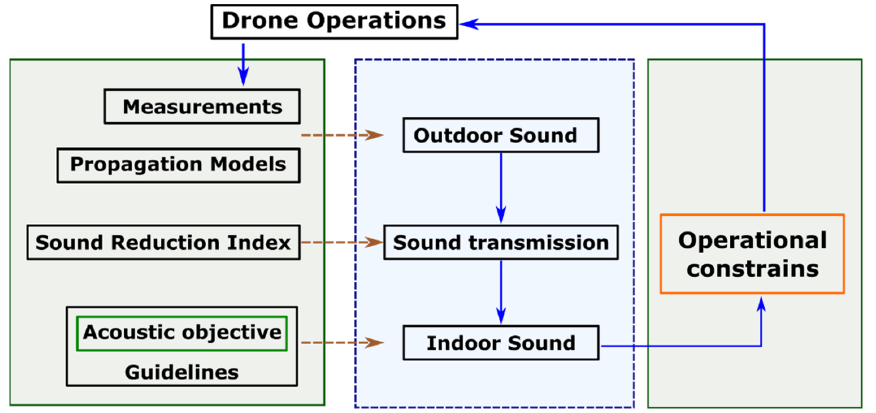
Figure 4. The modelling framework for the requirements of drone operations based on the guidelines for indoor acoustic objectives.